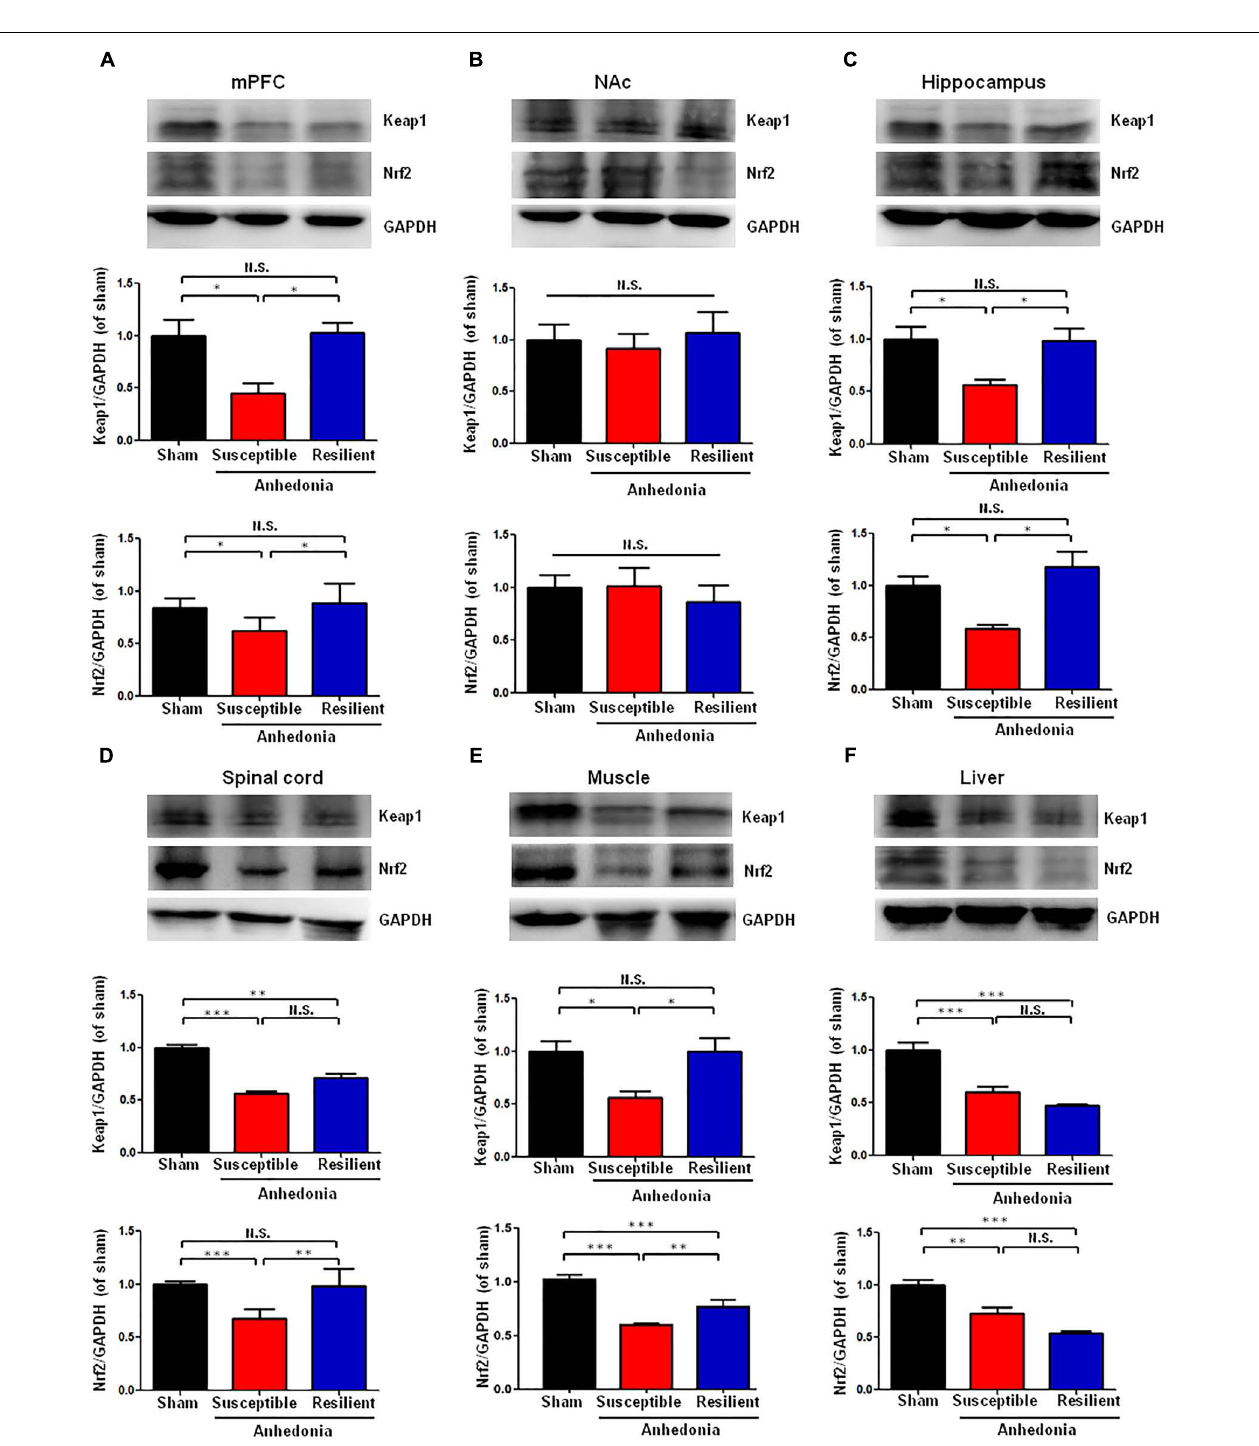
FIGURE 2 | Expression of Keap1 and Nrf2 proteins in selected tissues among the sham, anhedonia-susceptible, and anhedonia-resilient groups. (A) Keap1 [ F ( 2 , 15 ) = 9.477 , P = 0.02] and Nrf2 [ F ( 2 , 15 ) = 11.497 , P = 0.013] levels in the mPFC. (B) Keap1 [ F ( 2 , 15 ) = 1.811, P = 0.243] and Nrf2 [ F ( 2 , 15 ) = 0.289, P = 0.759] levels in the NAc. (C) Keap1 [ F ( 2 , 15 ) = 10.833 , P = 0.01] and Nrf2 [ F ( 2 , 15 ) = 9.248 , P = 0.015] levels in the hippocampus. (D) Keap1 [ F ( 2 , 15 ) = 62.237 , P = 0.011] and Nrf2 [ F ( 2 , 15 ) = 31.095 , P < 0.001] levels in the L2-5 spinal cord. (E) Keap1 [ F ( 2 , 15 ) = 6.35 , P = 0.033] and Nrf2 [ F ( 2 , 15 ) = 144.8 , P < 0.001] levels in the muscle. (F) Keap1 [ F ( 2 , 15 ) = 25.886 , P = 0.001] and Nrf2 [ F ( 2 , 15 ) = 22.201 , P = 0.002] levels in the liver. Data are shown as mean ± SEM ( n = 6). ∗ P < 0.05, ∗∗ P < 0.01, or ∗∗∗ P < 0.01. Keap1, kelch-like ECH-associated protein 1; mPFC, medial prefrontal cortex; NAc, nucleus accumbens; Nrf2, nuclear factor (erythroid 2-derived)-like 2; N.S., not